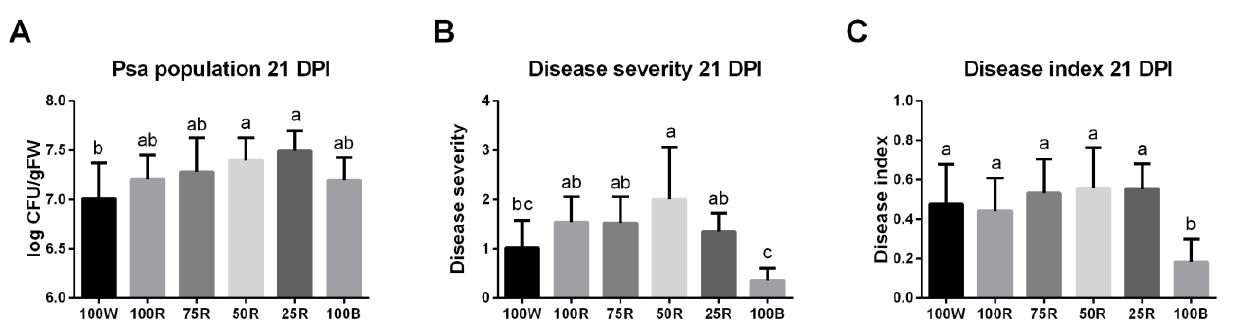
Figure 8. Effect of light quality on Psa population ( A ), Disease severity ( B ) and Disease index ( C ), 21 days post-inoculation (DPI). The values are presented as the mean of 3–5 biological replicates ± SE. Lowercase letters represent multiple comparisons of the light treatments. Mean values with the same letter are not significantly different (Fisher LSD, p < 0.05).